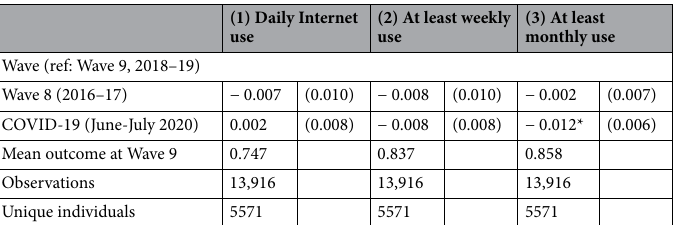
Table 2. Within-individual changes in Internet use. All are binary variables unless indicated otherwise. Figures in parentheses are standard errors. * P < 0.10, ** P < 0.05, *** P < 0.01.